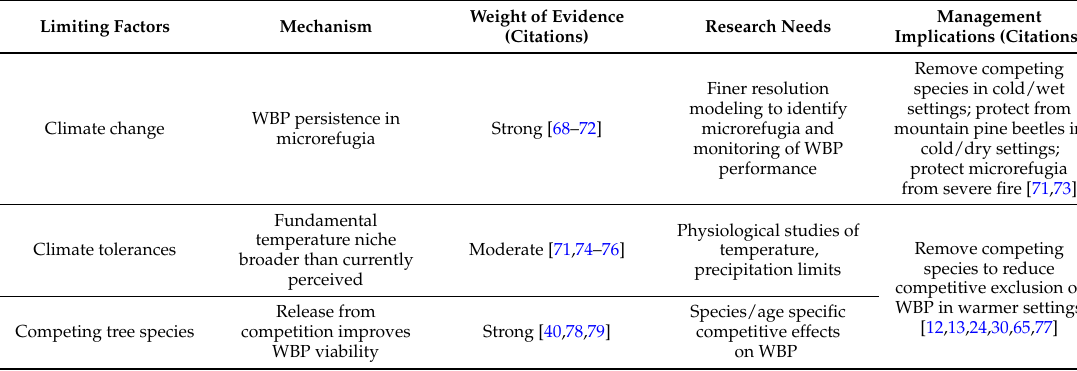
Table 3. Ecological mechanisms that may favor WBP population persistence under climate warming. Weight of evidence is based on current knowledge from the literature. Research needs and management implications are discussed in Sections 5 and